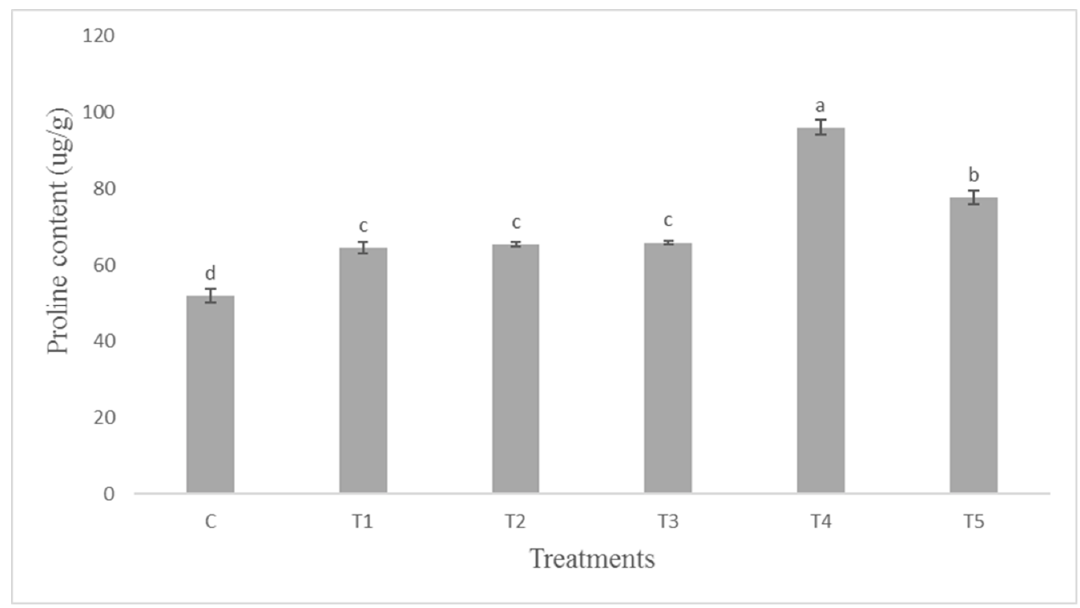
Figure 5. Proline content ( μ g/g) of tomato leaves infested with S. litura and under control condition. Data are means of four replicates along with standard error bars. Different letters are indicating significant differences ( p < 0.05) among treatments.